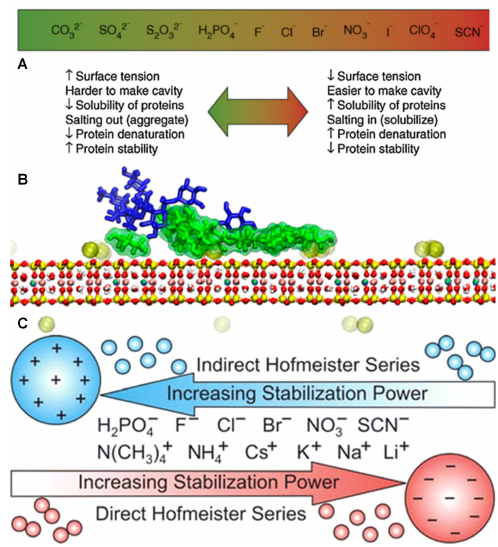
Figure 19. Effect of cations and anions at the interface. ( A ) Shows Hofmeister effect for anions and their physico-chemical implication; ( B ) Shows effect of counterion hydration on adhesion at a clay surface; ( C ) Shows effect of cations and anions on stabilization of polystyrene latex particles. Reprinted with permission from Refs. [174,175,180], respectively. c (cid:13) 2006 Elsevier; c (cid:13) 2014 American Chemical Society; c (cid:13) 2015 American Chemical